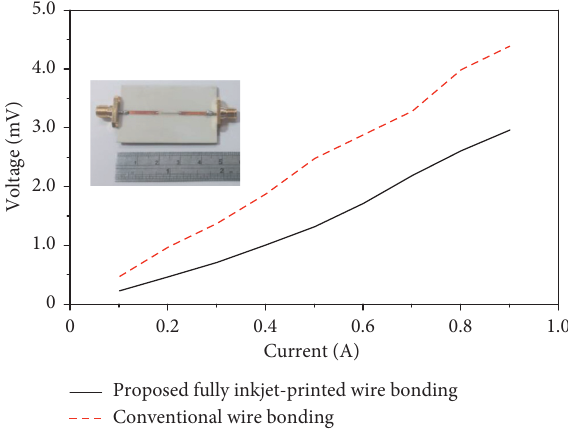
Figure 8: Comparison of the relationship between voltage and